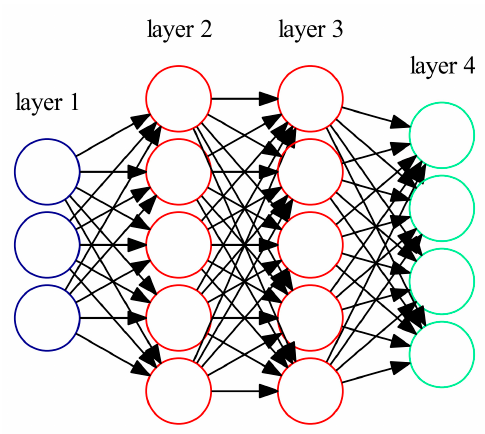
Figure 2. Forward propagation of deep neural networks with four layers.